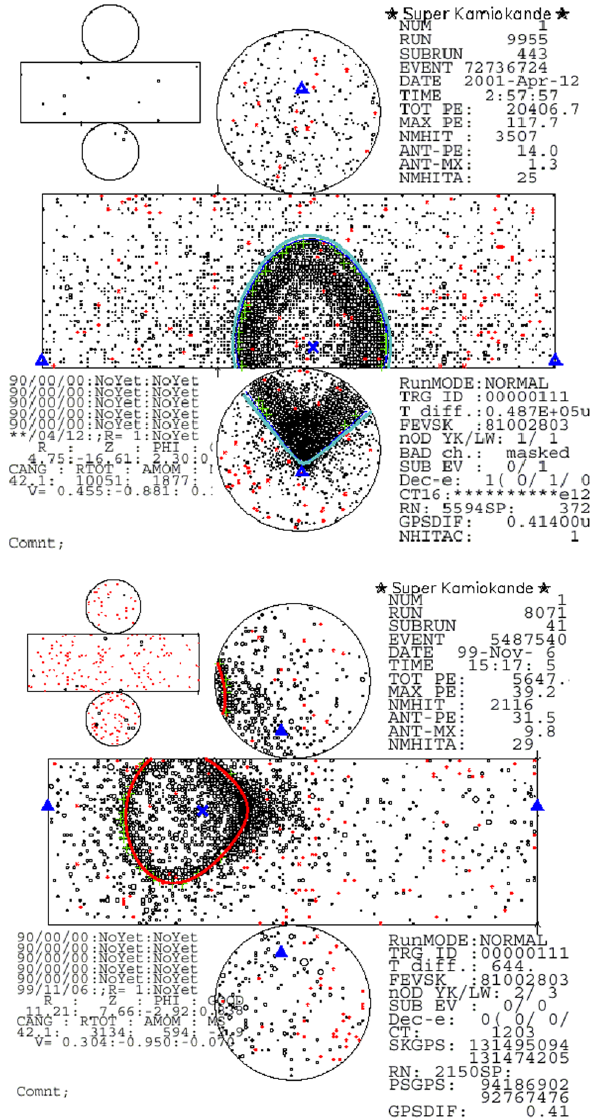
Fig. 1 An event with a single μ -like Cherenkov ring (top) and an event with an electro-magnetic shower-like ring (bottom) observed in K2K. The detector is a cylinder, lined with photomultiplier tubes. The center projection (unrolled cylinder) is the inner tank surface, and the projec- tion in the upper left corner is the outer detector